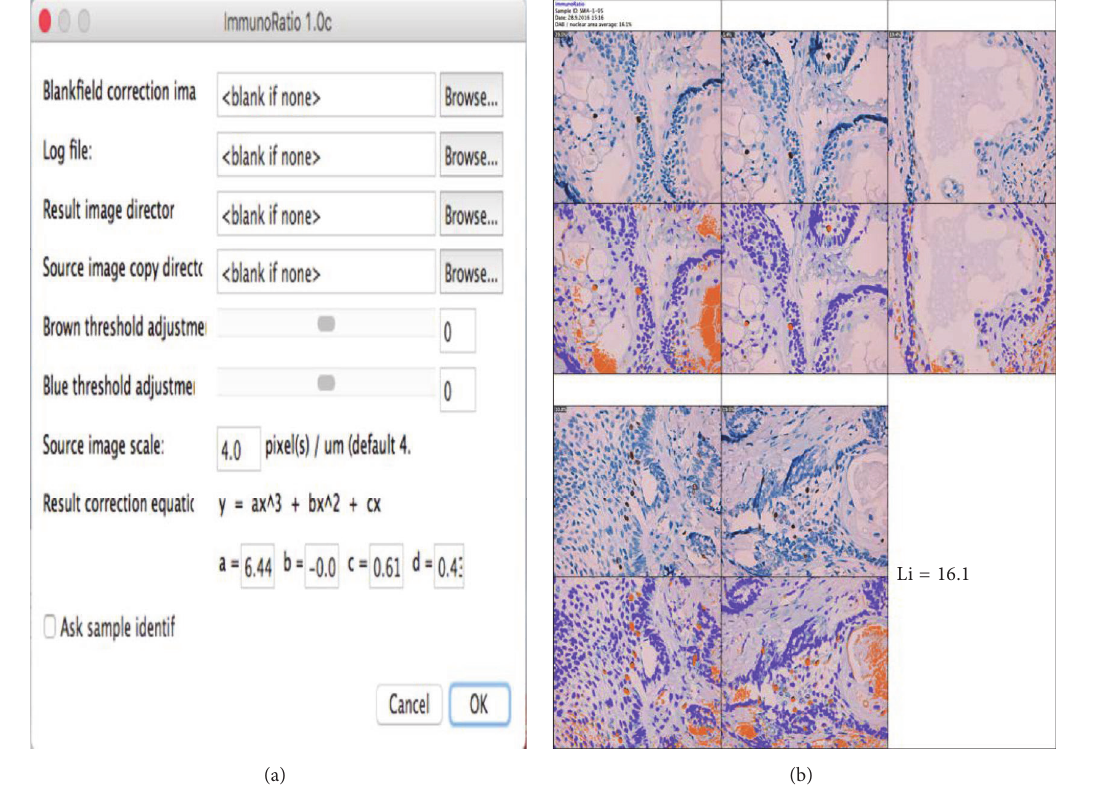
Figure 7: Photomicrographs of a solid ameloblastoma specimen at 400x magnification using the basic ImmunoRatio method with the ImageJ plugin (IRpB scoring). (a) Table of modifications that were not performed. (b) Cell counts for the original photomicrographs (top panel) and the pictorial montage (bottom panel) with false positives similar to those shown in Figure